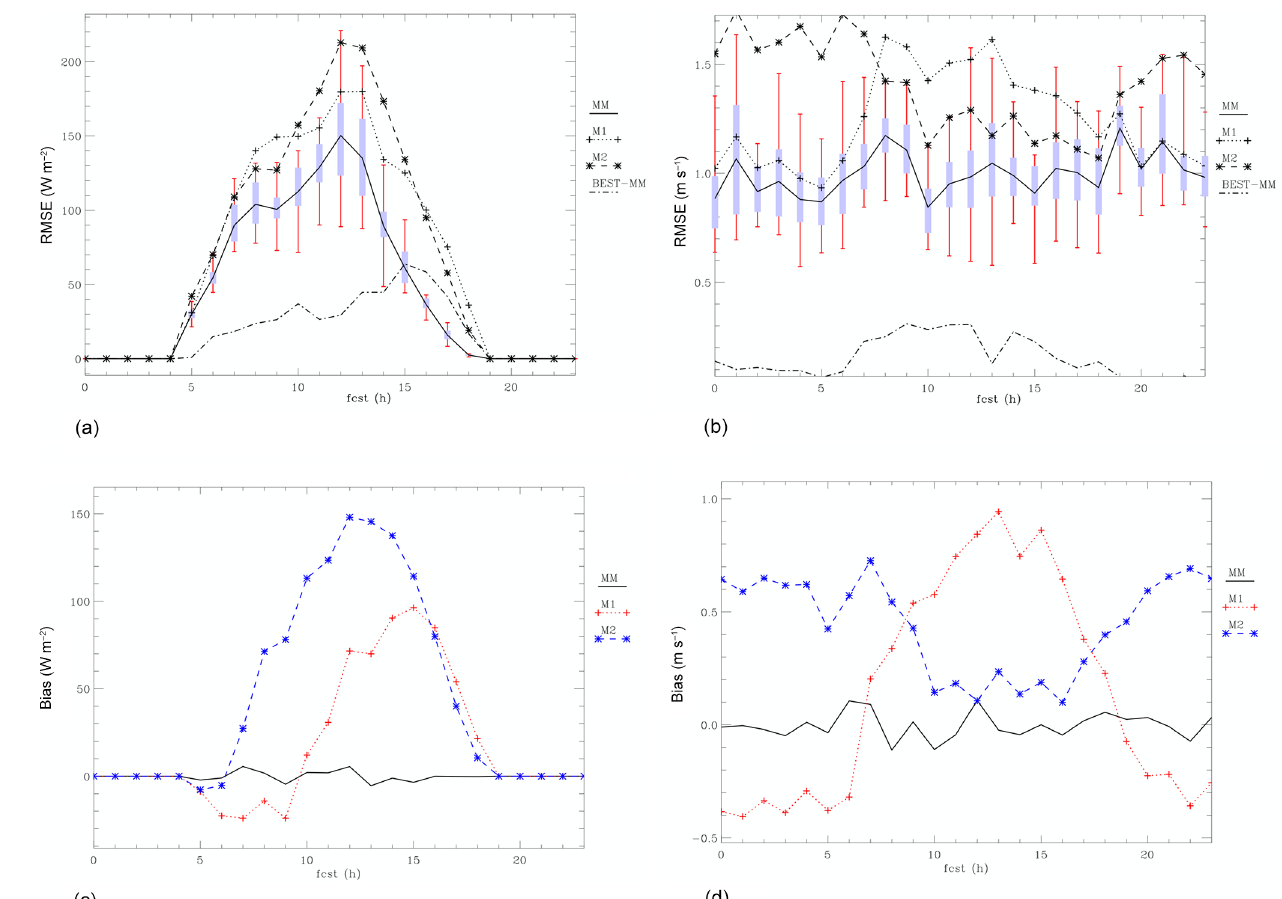
Figure 3. Same as Fig. 2 for the Lamezia Terme site.